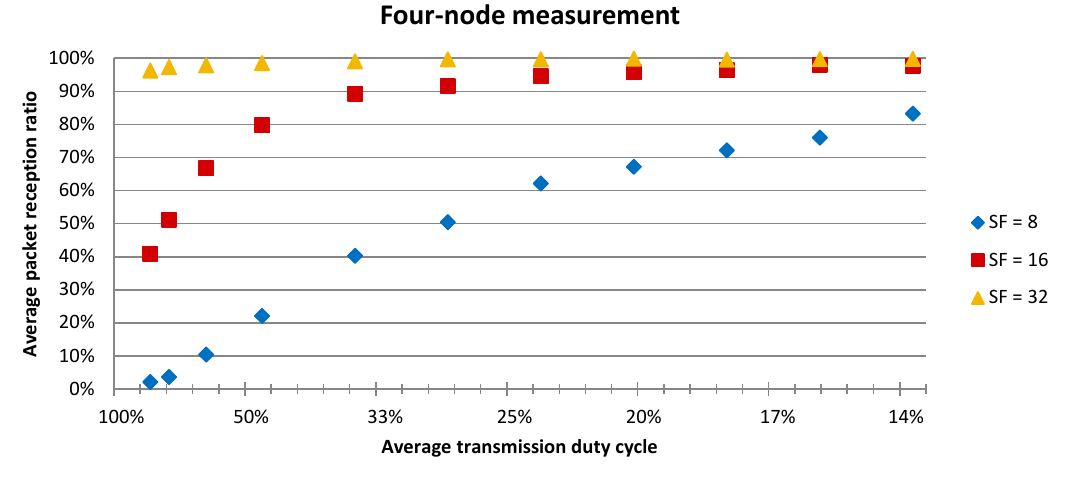
Figure 12. Packet reception ratio for the four-node setup under various traffic loads with spreading factors of 8, 16 and